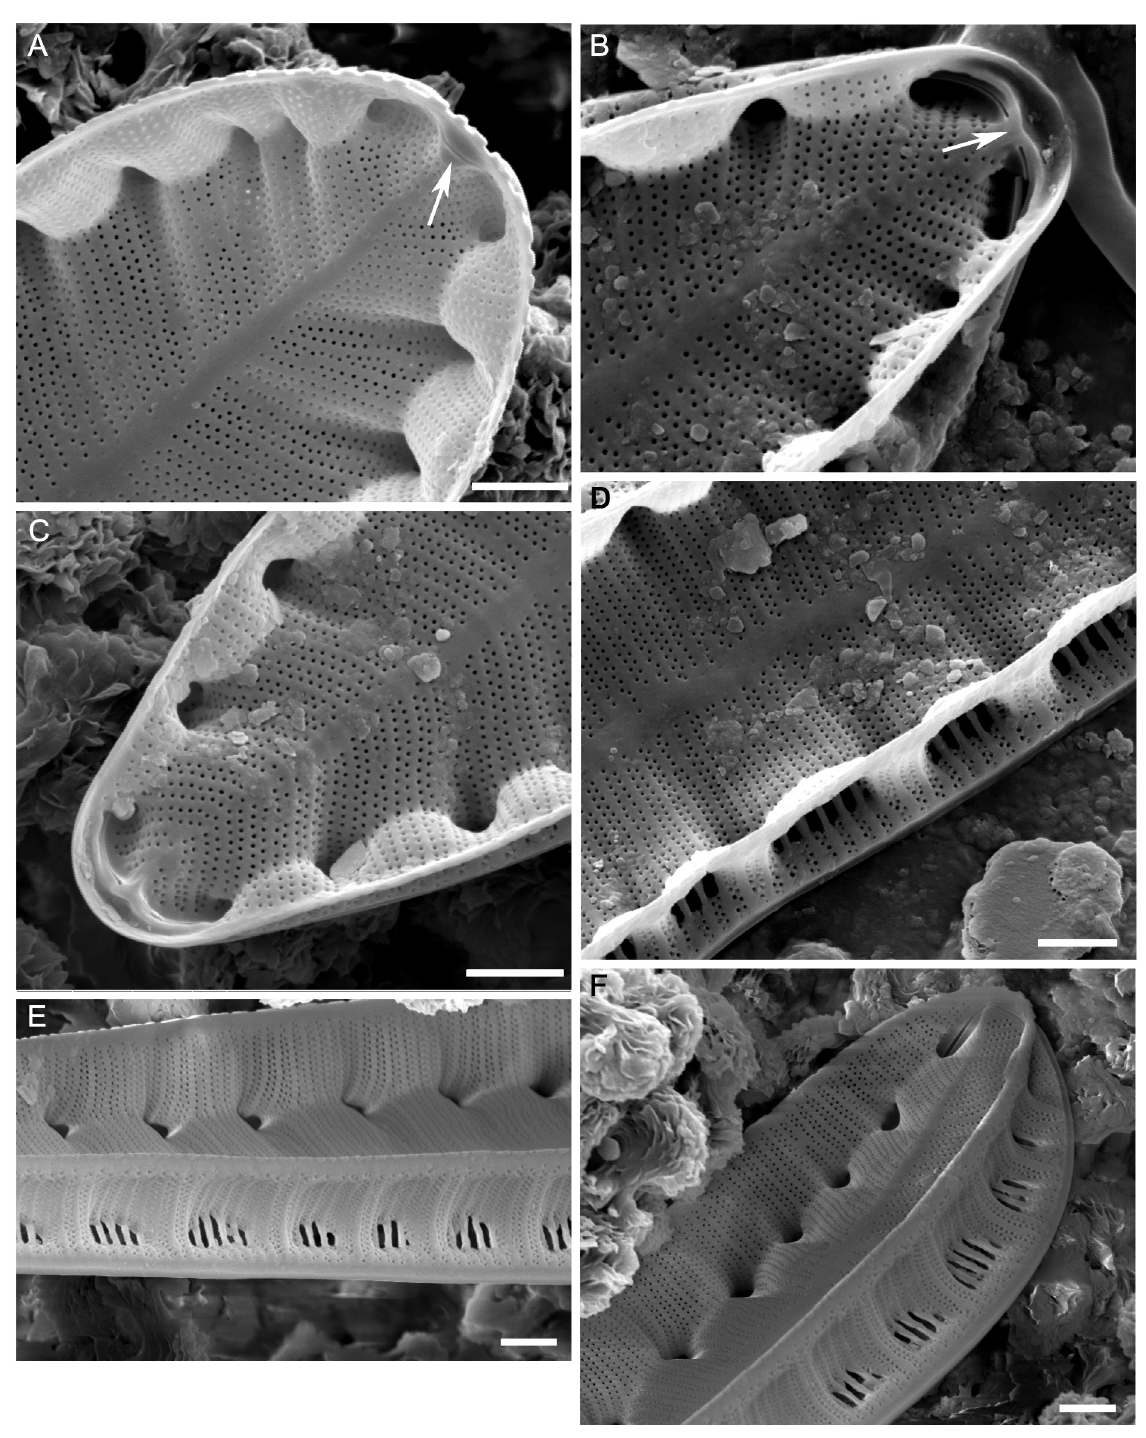
Fig. 9. Surirella congolensis sp. nov., type material from sample CCA 2071, Lomami River, DR Congo, SEM. Internal view. A–B . Head pole showing the continuous raphe (arrow). C–D . Foot pole showing the interruption of the raphe and the straight slightly expanded terminal raphe endings. E–F . Detail of the alar canals. Scale bars: B–C = 2 µm; A, D = 1